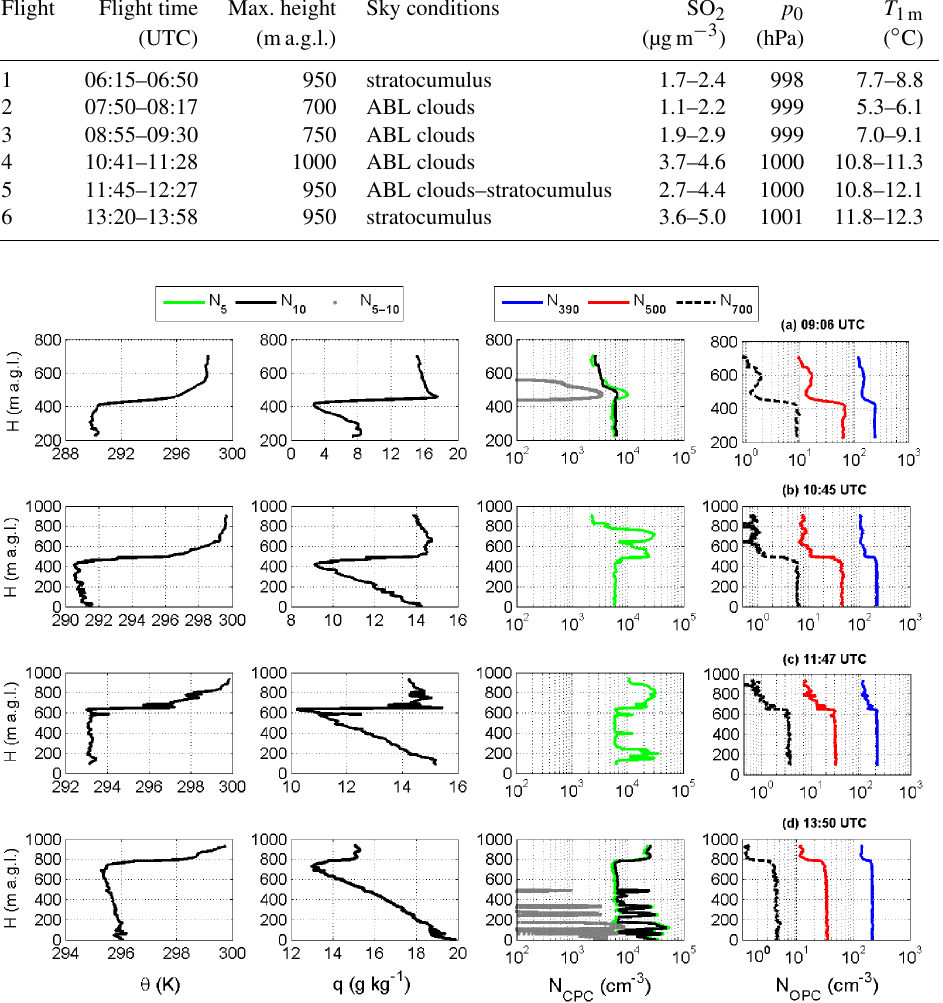
Table 1. Airborne measurements performed with the UAS ALADINA during Case I on 4 April 2014. The flight time of ALADINA between take-off and landing and the maximum altitude of flights are shown. In addition, prevailing conditions of clouds, SO 2 gas concentration, pressure at the surface p 0 and temperature T 1m from mast in 1m height are presented in relation to the corresponding flights. Flight